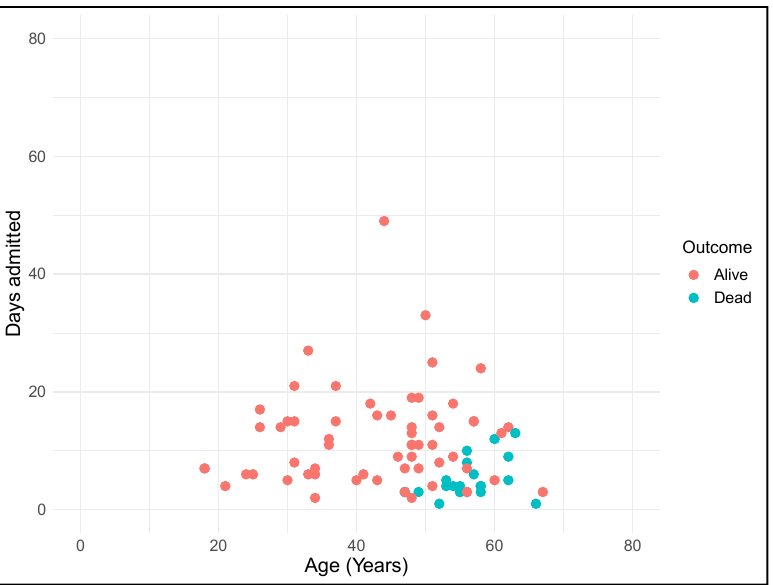
Figure 1. Distribution of hospitalization length of stay for individuals with DS with COVID-19 (T21RS cohort) according to age and outcome. Data extracted only from clinicians’ surveys.